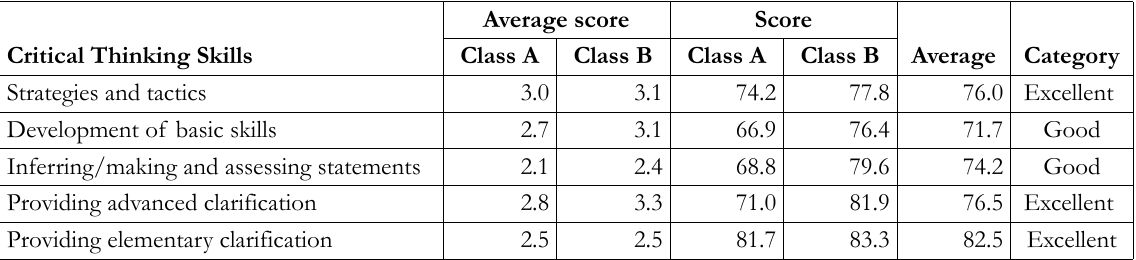
Table 5. Students’ critical thinking skills in basics of analytical chemistry course